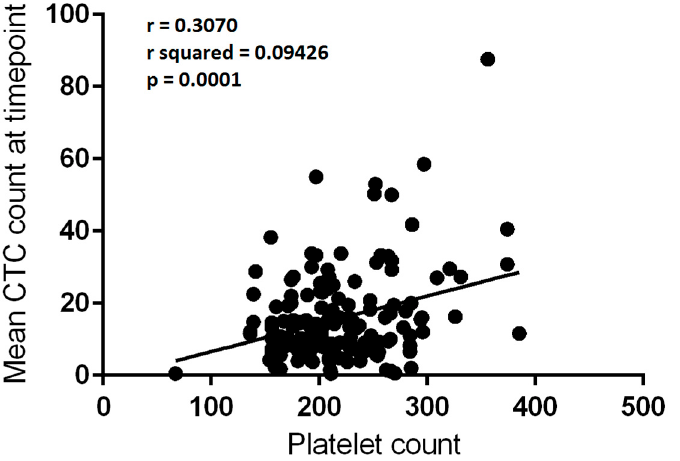
Figure 3. Correlation between platelet count (×10 9 /L) and mean circulating tumour cell (CTC) count per 3mL of blood at a given blood draw ( n = 150). Linear regression, r = 0.3070; r 2 = 0.09426; p = 0.0001.